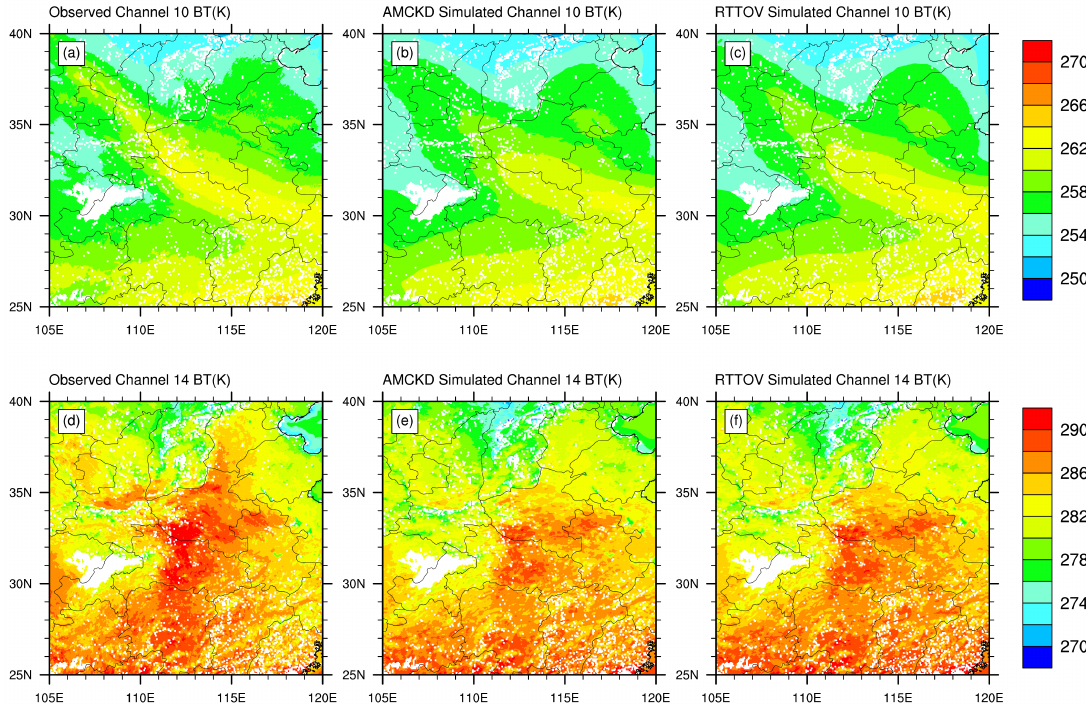
Figure 5. Comparison between simulated brightness temperature by AMCKD ( b , e ), RTTOV ( c , f ) and observations ( a , c ) of AHI 7.3471 µ m (channel 10) ( a – c ) and 11.2432 µ m (channel 14) ( d – f ) channels with a clear sky. The blank area is the cloudy area.